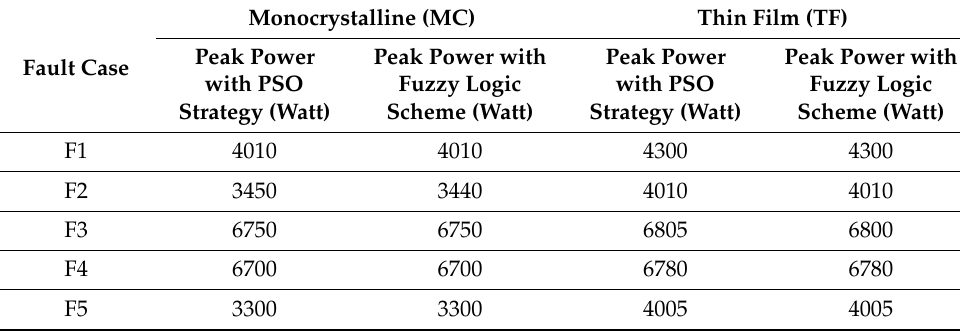
Table 5. Computed values of the PV system under various faults.